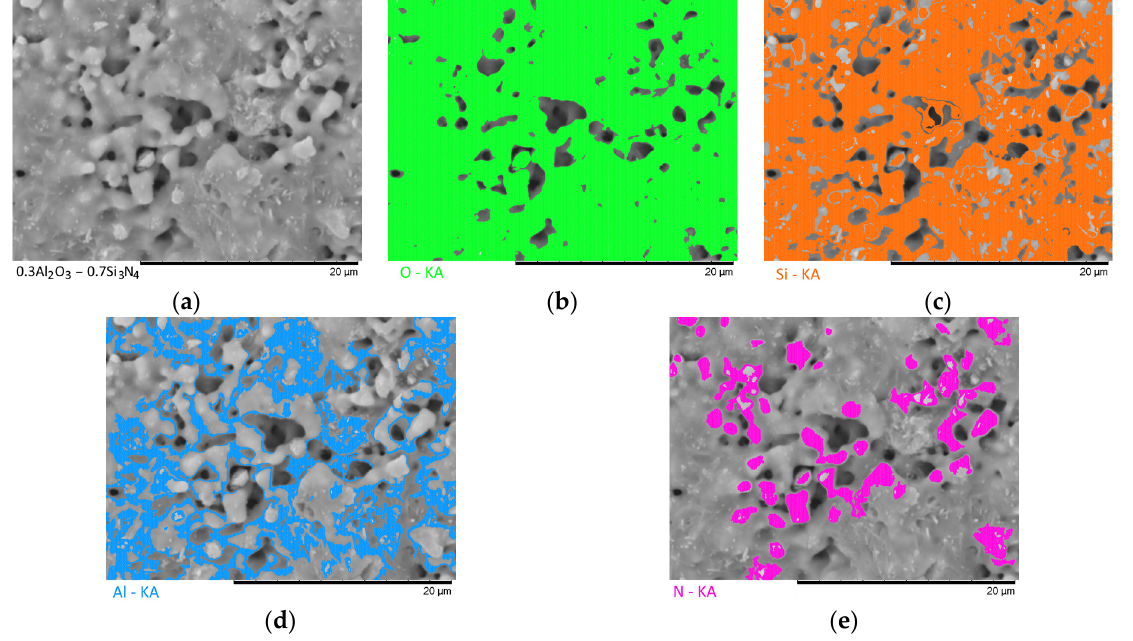
Figure 5. Results of morphological studies and mapping of a ceramic sample with an Al 2 O 3 content of 0.3 mol: ( a ) SEM image; ( b ) oxygen distribution results; ( c ) silicon distribution results; ( d ) aluminum distribution results; ( e ) nitrogen distribution results